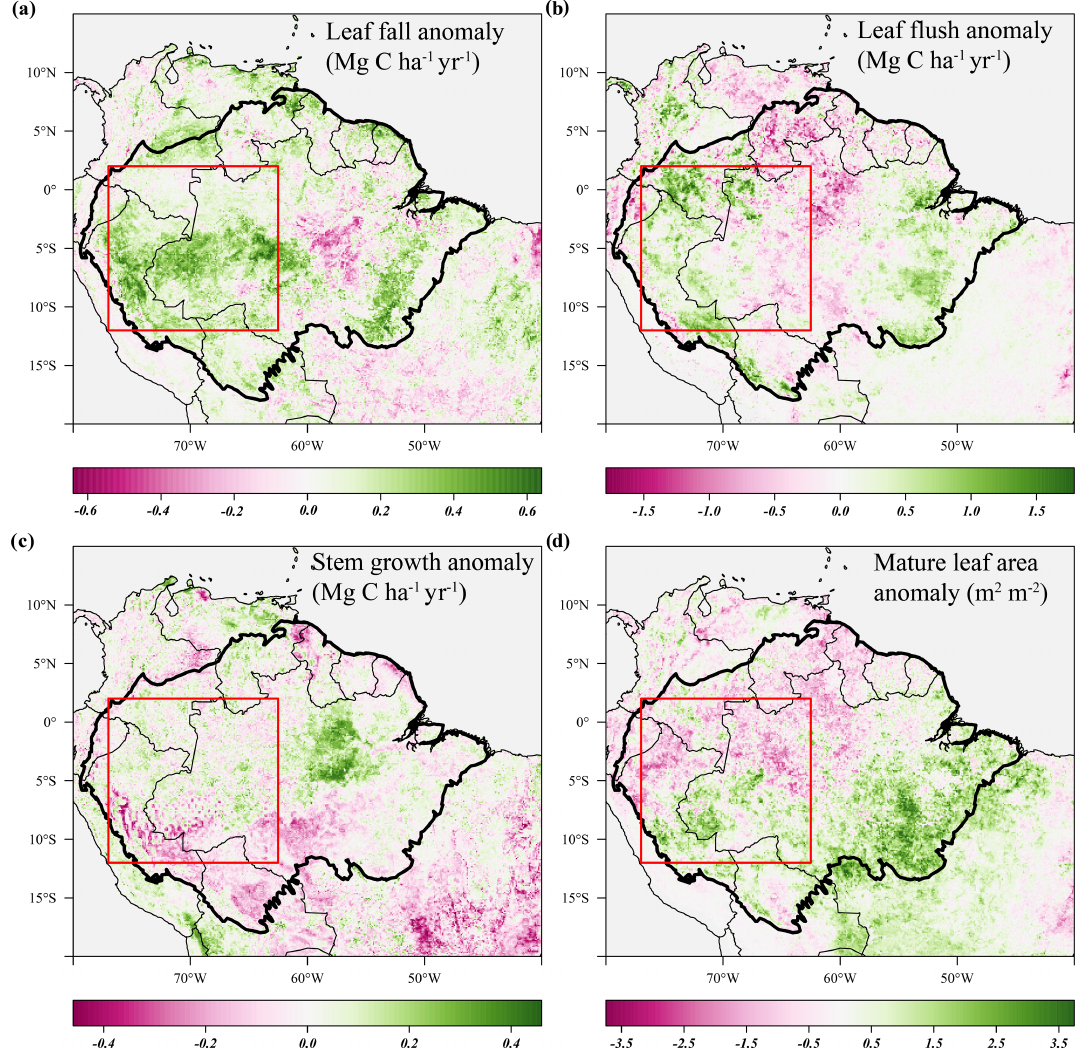
Figure 6. Average anomalies in leaf fall, leaf flushing, and stem growth and mature leaf area during the 2005 drought (June–September 2005) compared to their long-term monthly averages (1982–2019). Leaf fall (a) and stem growth (c) were directly retrieved from the long-term monthly model estimates. Leaf flush (b) was calculated from monthly predicted leaf fall (a) and changes in LAI. Mature leaf area (d) is the sum of new leaf area flushed in the previous 2 to 5 months. Country borders and the extent of the Amazon basin are marked by thin and thick black lines, respectively. The red rectangle delineates the drought area for which further results are